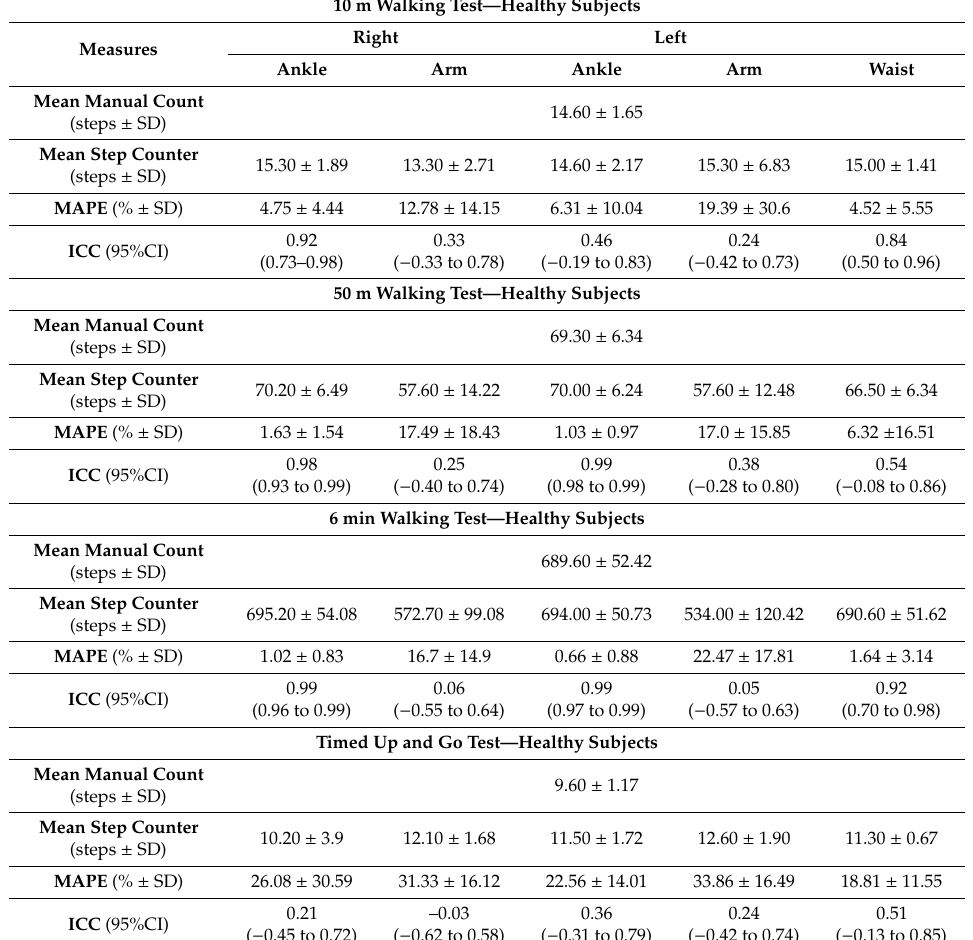
Figure 2. Comparison of the mean absolute percentage error in the 50 m walking test (50 m WT) for the healthy group ( n = 10), pathological group ( n = 43), and group V3 ( n = 17). Legend: P: pathological group; H: healthy group; *: p < 0.05.